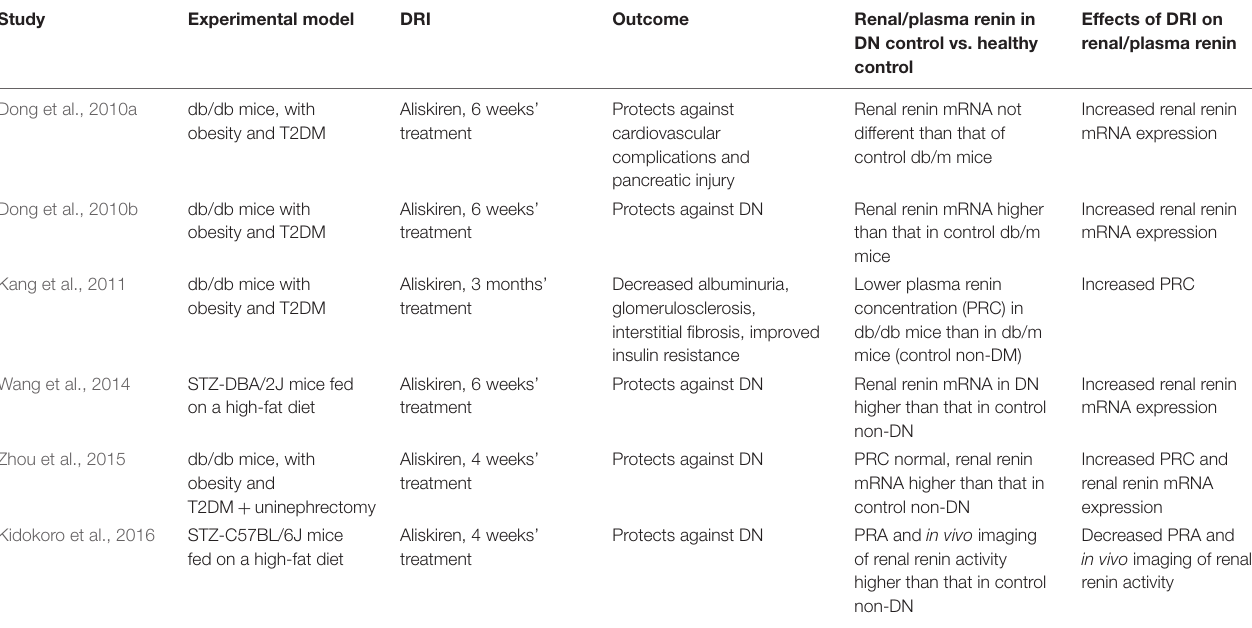
TABLE 2 | Preclinical studies with DRI in diabetic nephropathy that determined plasma renin or renal